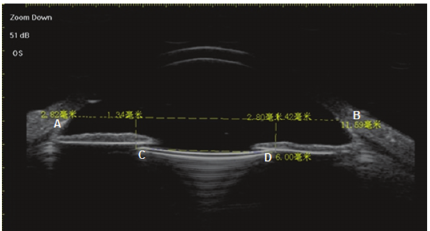
Figure 2: Measurement of IOL decentration (A, B = scleral spur, C, D = two optical endpoints of IOL).